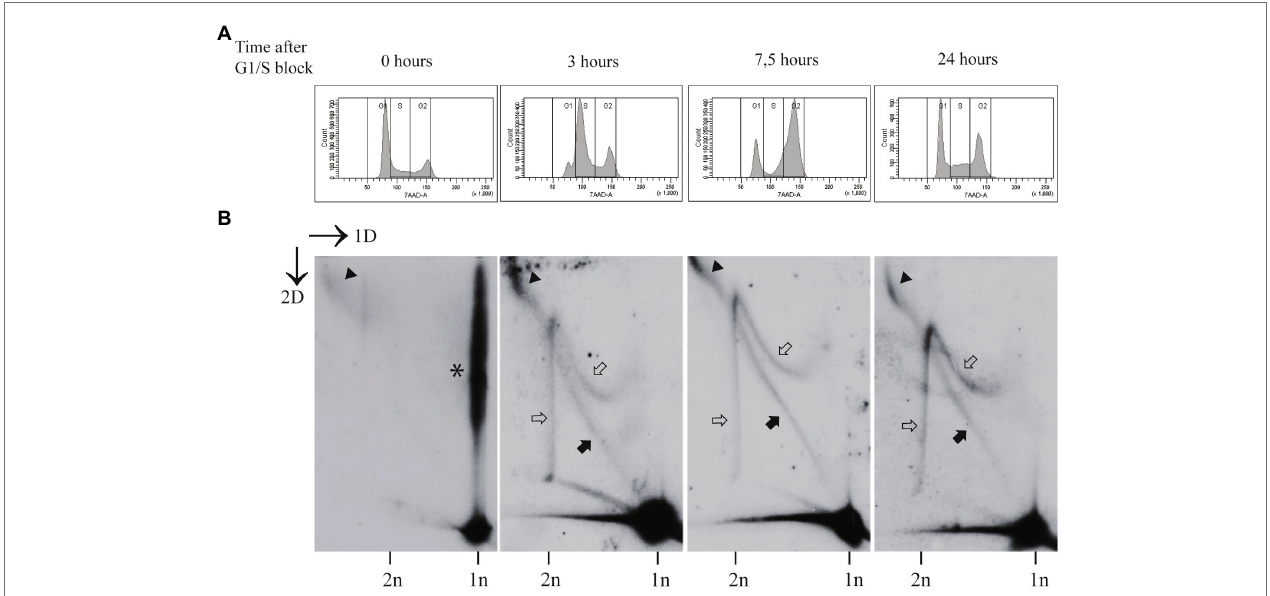
FIGURE 3 | The non-theta replication of the HPV18 genomes is dependent on the replicative DNA polymerase(s). (A) The cell cycle profile of the aphidicolin arrested cells (0 h), followed by the release into the cell cycle at various time points (3, 7.5, and 24 h) post-arrest. The U2OS cells were transfected with the HPV18 genome, 48 h after the transfection the cells were arrested at G1/S phase using aphidicolin treatment (2 μ g/ml) for 24 h, followed by the removal of the drug and release of the cells to cycling conditions for the indicated periods of time. (B) Neutral-neutral 2D analysis of the replication intermediates arising from the HPV18 genome replication after the transfection into the U2OS cells at various time points after the G1/S block using aphidicolin. Nearly all replication intermediates are absent at the end of 24-h block by aphidicolin (0 h). Instead, the collapsed intermediates migrate above the 1n linear molecule spot (indicated by asterisk). At 3 h post-release, when majority of the cells have entered the S-phase, both theta and non-theta type of replication intermediates are present. About 7.5 h after the release majority of the cells have entered G2/M phase, and still both type of replication intermediates are detectable. At 24 h post-release, the cells have restored the normal distribution of the cell cycle and both theta- and non-theta replication intermediates can be seen. Black arrows refer to the theta replication intermediates, black arrowheads refer to the almost fully replicated genomes, and white arrows refer to the non-theta replication